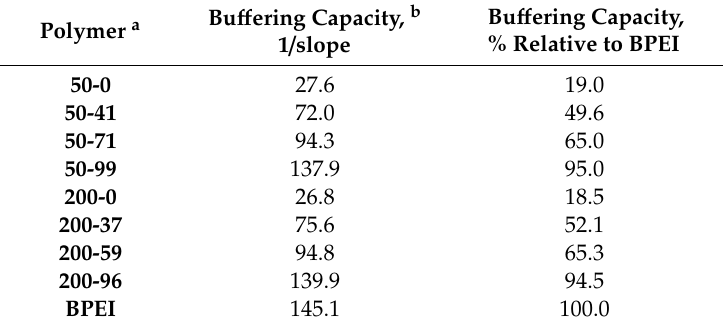
Table 4. Bu ff ering capacity of PMeOx–PEI copolymers di ff ering by degree of polymerization (DP) (50 and 200) and DH (37–99%). The copolymer concentration was 0.5 mg / mL. a—the first and second digits correspond to DP and DH, respectively. b—the slope is determined from the titration curves. Adapted from Haladjova et al. as published by the Wiley Periodicals LLC